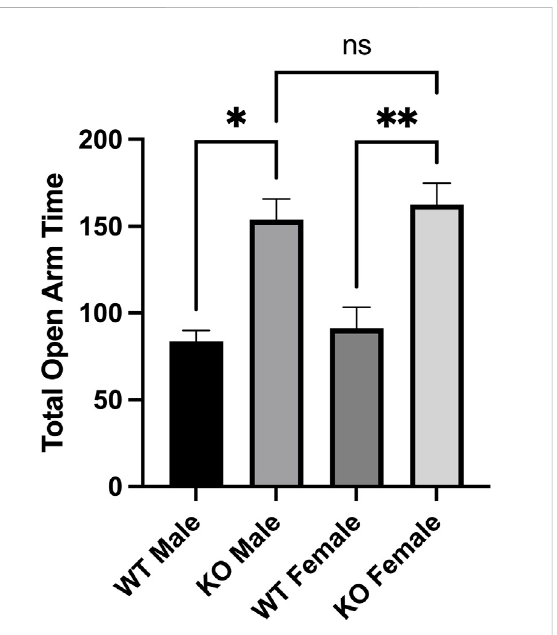
FIGURE 5 AMPH treatment reduced anxiety-like behaviors in Sirt3-KO male and female mice in the elevated plus maze paradigm. (A-B) Histograms show the mean and SEM of the plus maze test measuring the total amount that male and female mice treatedwitheithersalineor1 mg/kgAMPHspentintheopenareas of the elevated plus maze during a 5-min test period. Data are presented as the behavioral output observed in subjects that received AMPH normalized to those that received saline injection. (A-B) AMPH treated male and female mice spent more time in the open arms than those treated with saline. Asterisks denote ( p < 0.05), two-way ANOVA (male independent subjects: saline n = 8, AMPH n = 9; female independent subjects: saline n = 7, AMPH n =